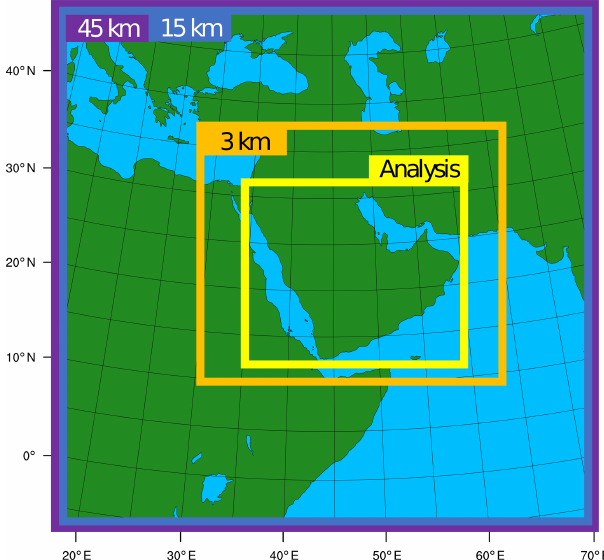
Figure 3. Model domain setup and analysis region for the 45km (purple) and 15km (blue) independent simulations with cumulus parameterizations as well as the 3km nested convection-permitting simulation (orange). The averaging region for the analysis is de- noted in